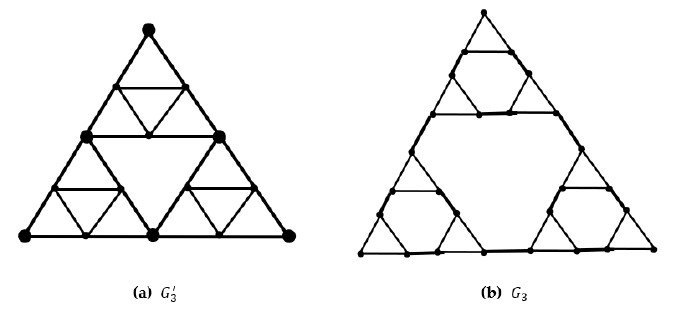
Figure 6. ( a ) Noncanonical 𝐺 (cid:2871)(cid:4593) ; ( b ) canonical 𝐺 (cid:2871) .